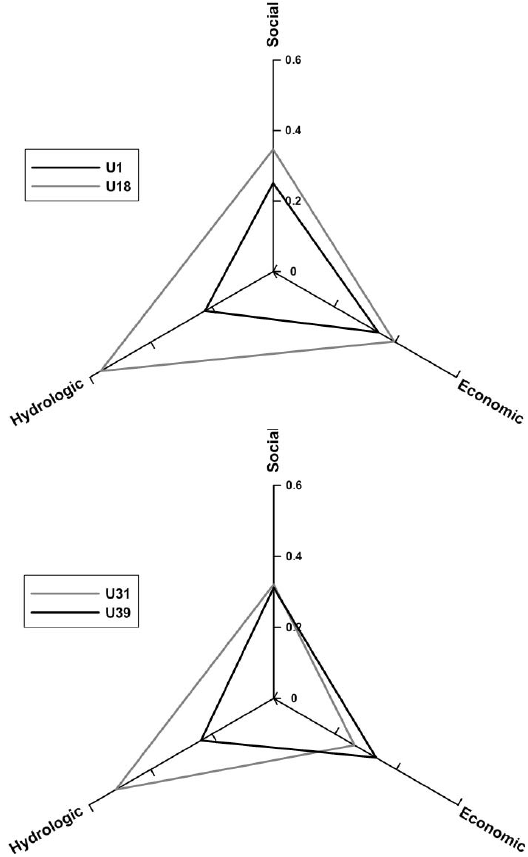
Fig. 11. Comparison of social, economic and hydrologic vulnera- bility.